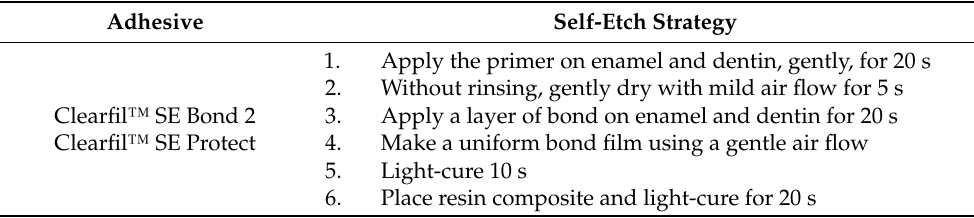
Table 2. Adhesive type and adhesive strategy, step-by-step, used during sample preparation.